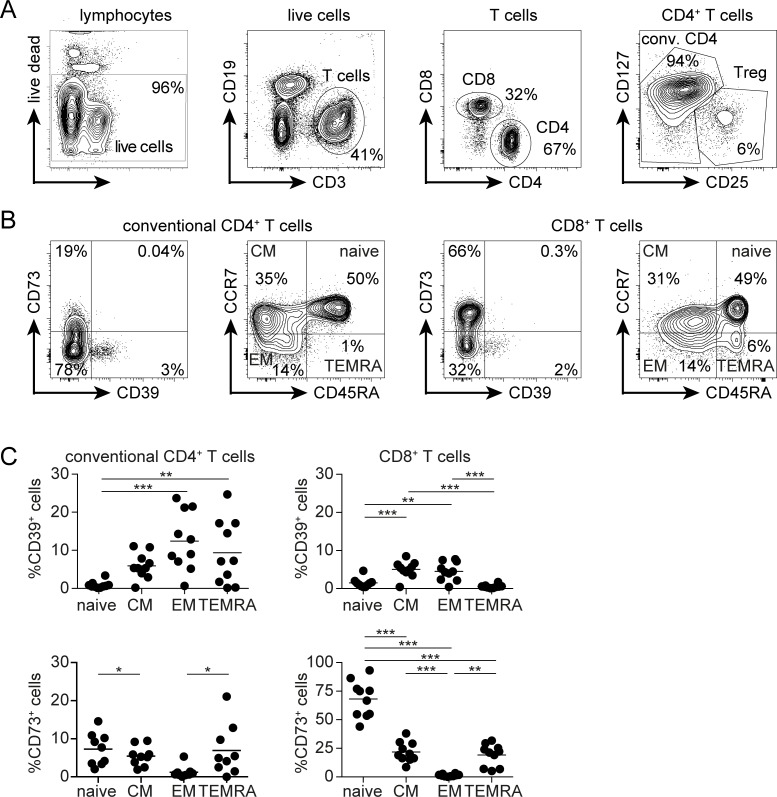
CD39 and CD73 expression profiles of human peripheral blood T-cell subsets.(A) Gating strategy for conventional CD4+ and CD8+ T cells from human peripheral blood. CD25+CD127— Treg cells were excluded. (B) CD39 and CD73 as well as CCR7 and CD45RA expression profile of conventional CD4+ and CD8+ T cells. Naive: CCR7+CD45RA+, effector/effector memory (EM): CCR7—CD45RA—, central memory (CM): CCR7+CD45RA— and TEMRA: CCR7—CD45RA+. (C) Percentages of CD39 and CD73 expression on CD4+ and CD8+ T-cell subsets from the blood of 10 healthy donors and the means are shown. ANOVA multiple comparison, * p<0.05, ** p<0.01, *** p<0.001.